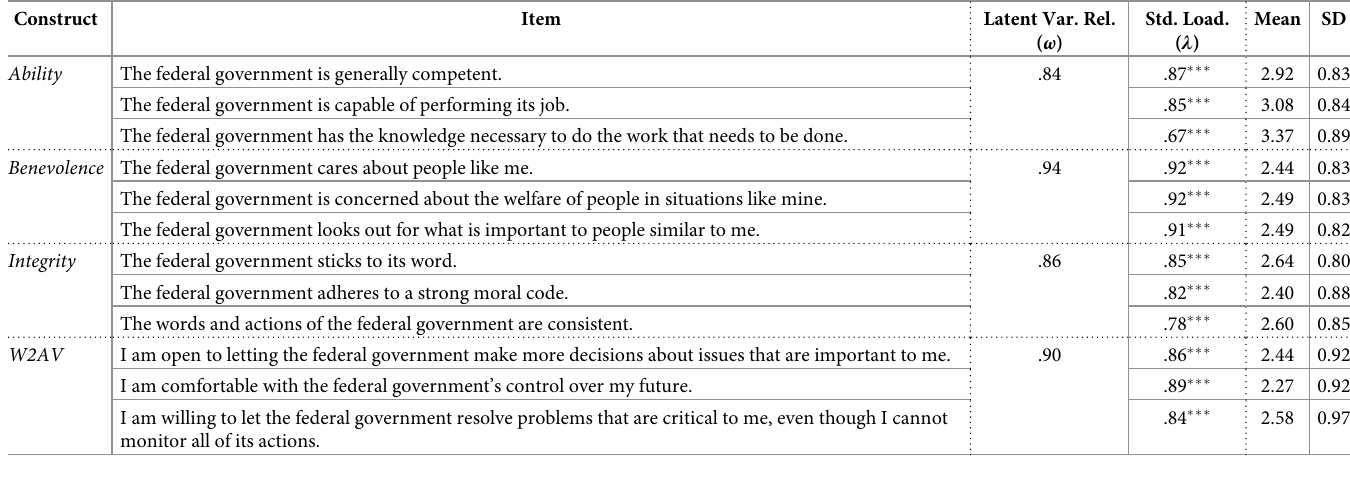
Table 1. Confirmatory factor analysis results and item univariates.